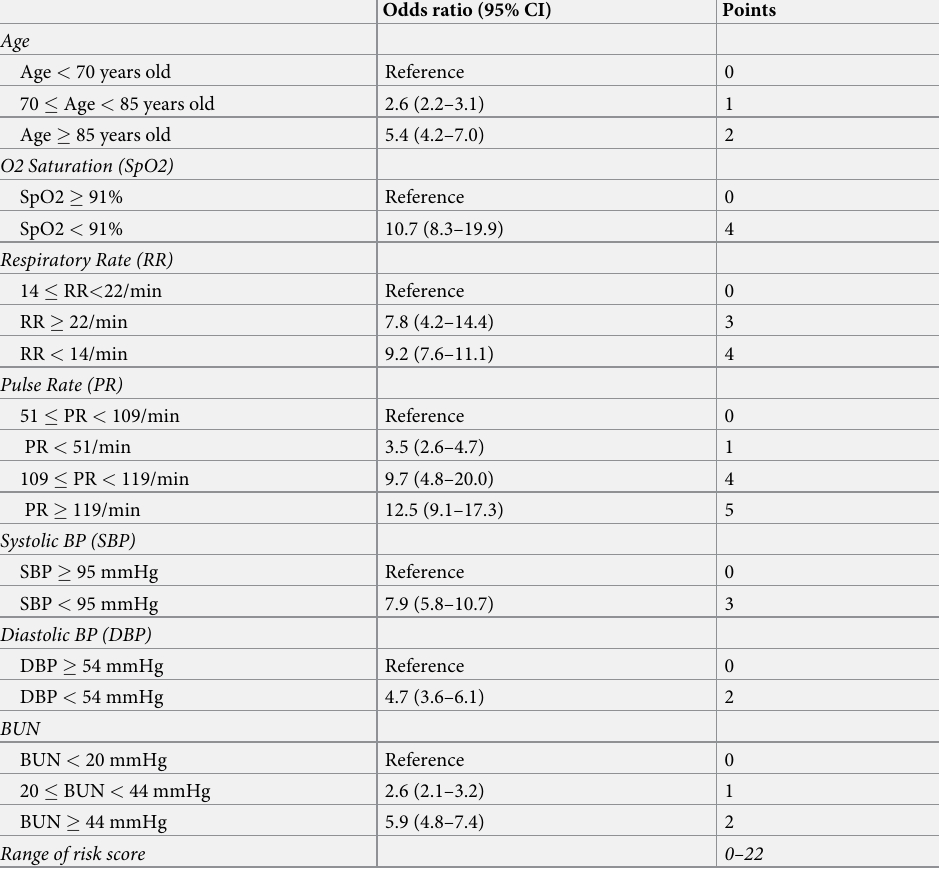
Table 2. Predictors from the multivariable model and points indicating an increased risk of